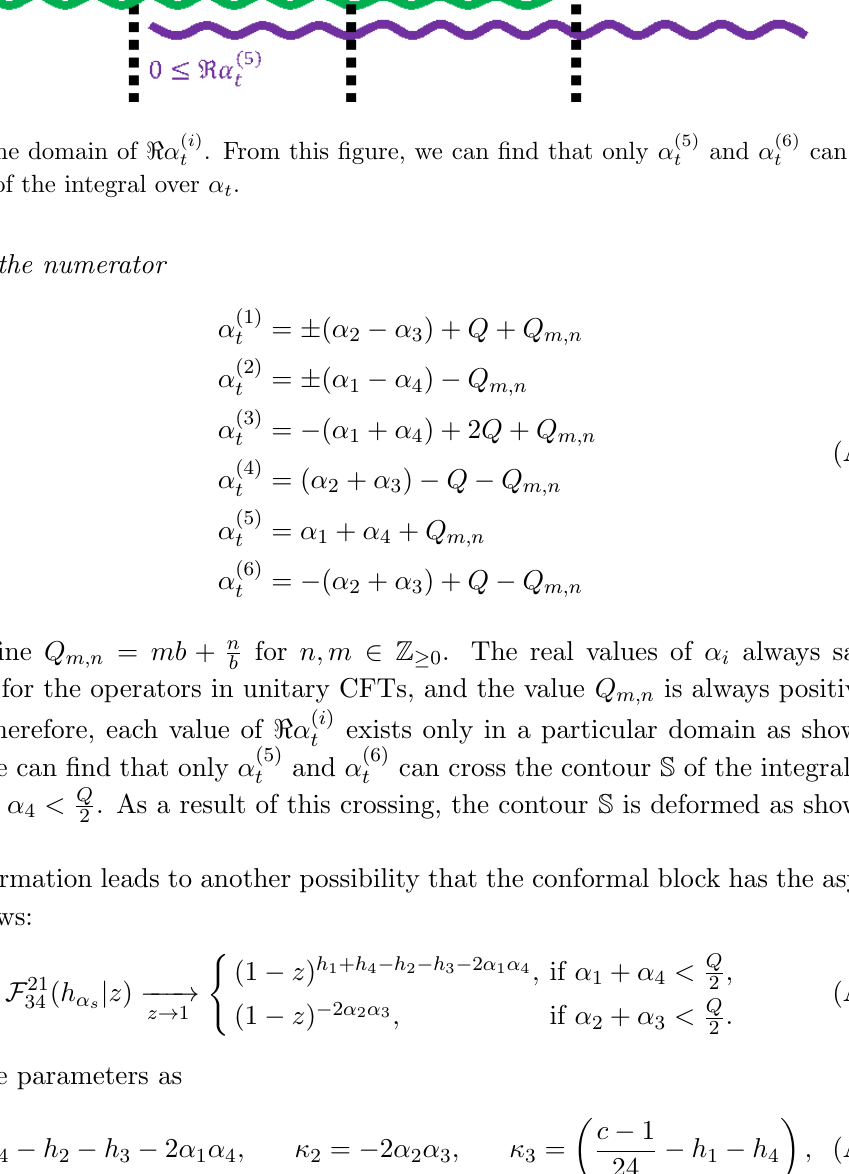
. From this (cid:12)gure, we can (cid:12)nd that only (cid:11) (5) t